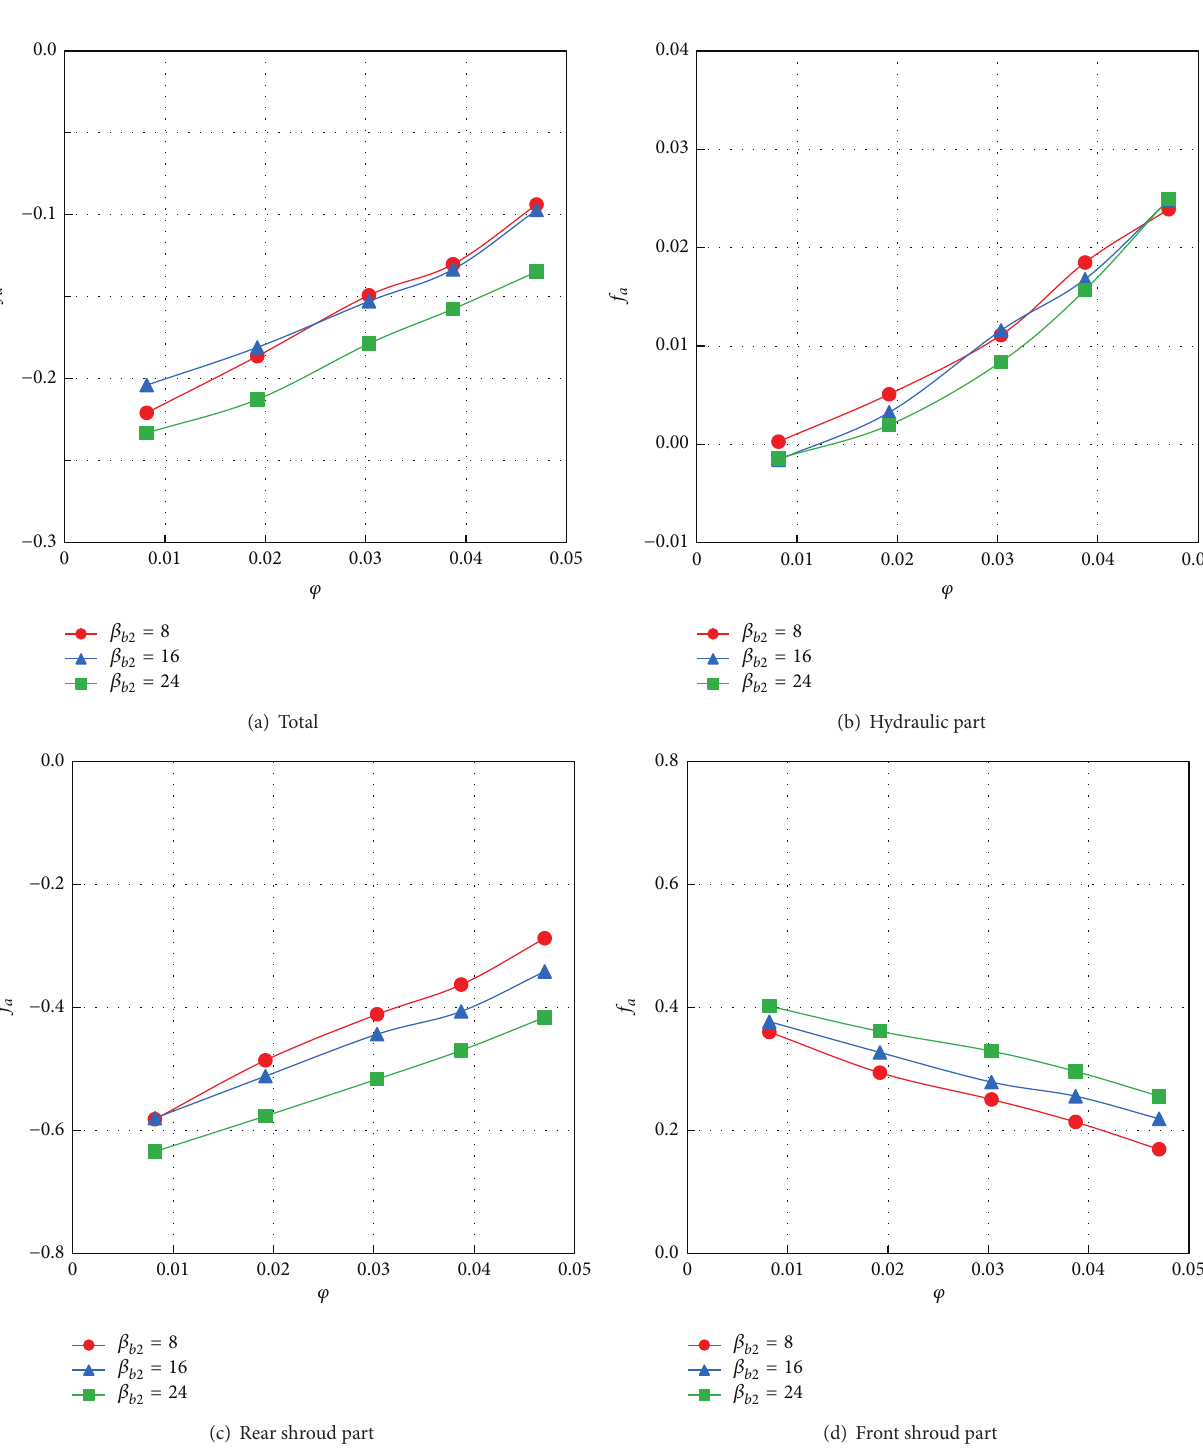
Flow into the impeller shifted from the axial direction to the radial direction and received a counteracting force in the +𝑧 direction. The momentum component was the force on the impeller; the momentum increased with an increase in flow rate, thus increasing the momentum component. For every